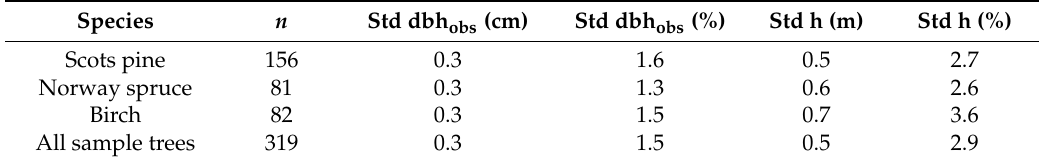
Table 5. The species specific means of the standard deviations (std) calculated from the four independent dbh obs (diameter-at-breast-height) and h (height) observations from each of the sample